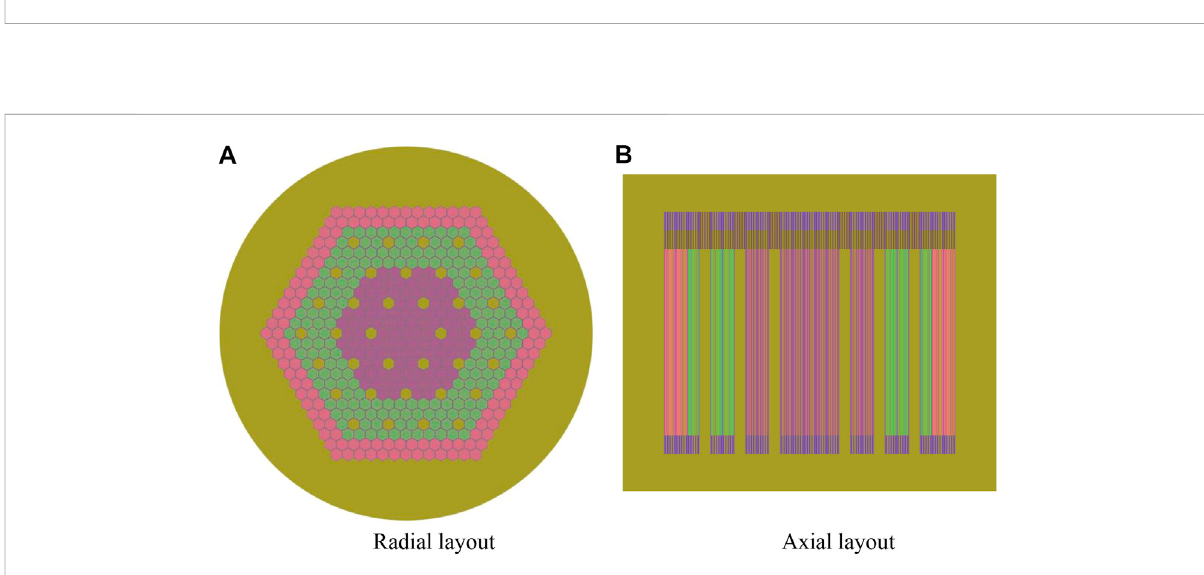
FIGURE 3 300-MWt core arrangement diagrams of UO 2 and U-10Zr: (A) radial layout and (B) axial